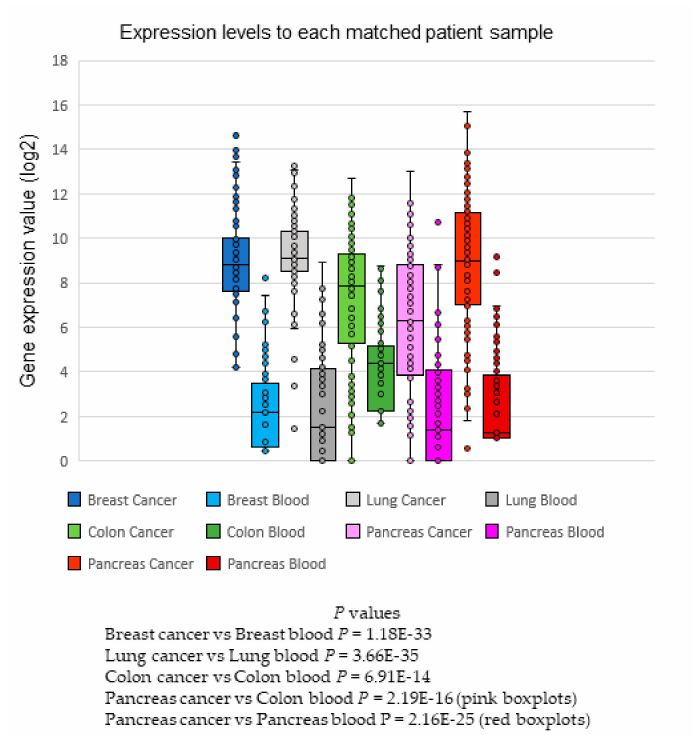
Figure 5. Expression of the 80 genes in 4 di ff erent malignant tumors with the blood pair. Boxplots show the expression of the 80 genes in 4 di ff erent malignant tumors with the blood pair, including breast, lung, two cases of pancreatic cancer, and colon cancer. The means of expression (log2) for tumors are visible above 8–10 (except for the two cases of pancreatic cancer), and below 4 for blood samples (except for one case of pancreatic cancer, shown as the pink